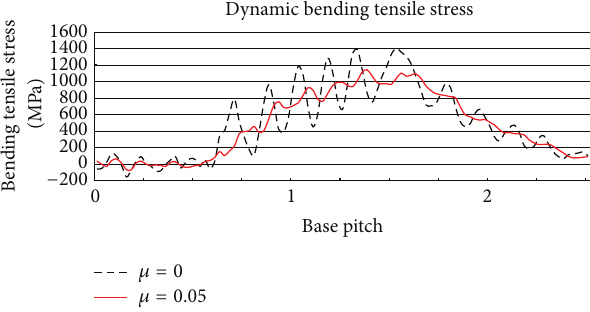
Figure 8: Dynamic bending tensile stress results ( 𝜔 =